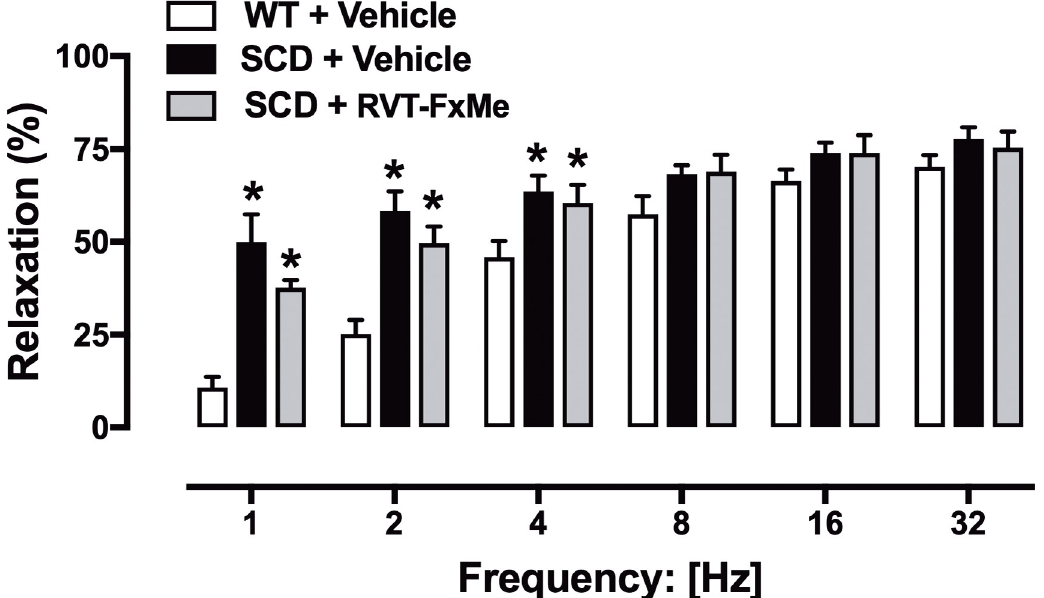
Fig 6. Relaxation responses to electrical-field stimulation (EFS) in corpus cavernosum strips from WT and SCD mice treated with RVT-FxMe (25 mg/kg/day, 2 weeks) or vehicle. Data were calculated relative to the maximal changes from the contraction produced by phenylephrine (10 − 5 M for WT mice and 3 × 10 − 6 M for SCD mice) in each tissue, which was taken as 100%. Data represent the mean ± SEM for 6 mice in each group. � P < .05 vs WT + Vehicle.